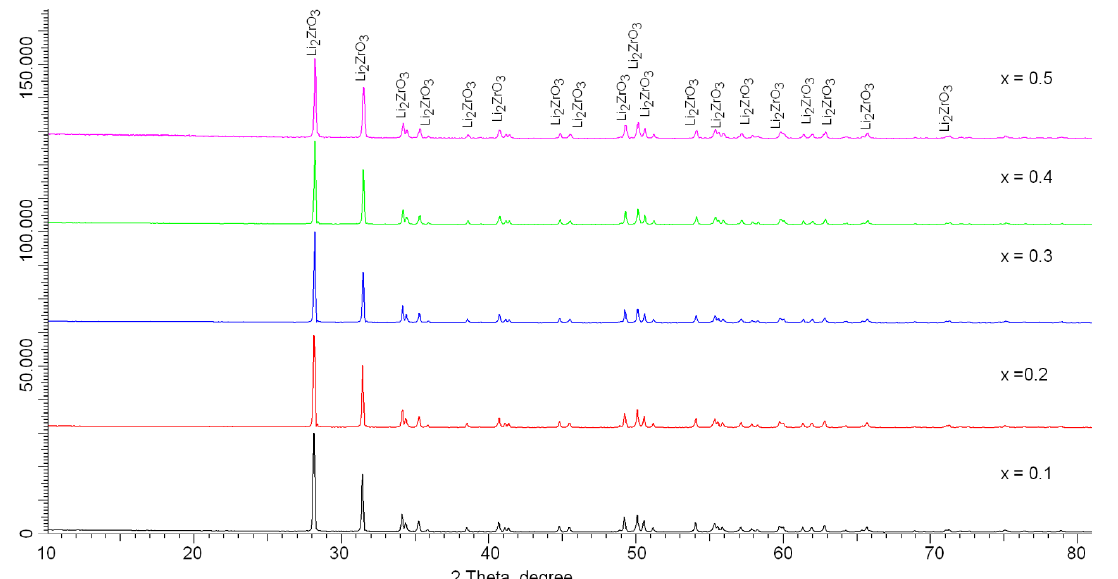
Table 1. Unit-cell parameters and crystallinity characteristics for Li 2 ZrO 3 ceramics.